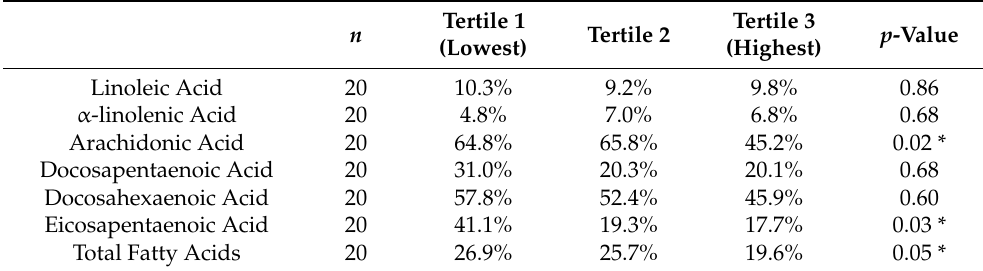
Table 6. Kruskal–Wallis Test of Intrauterine Transfer Percentage by Maternal Plasma Level